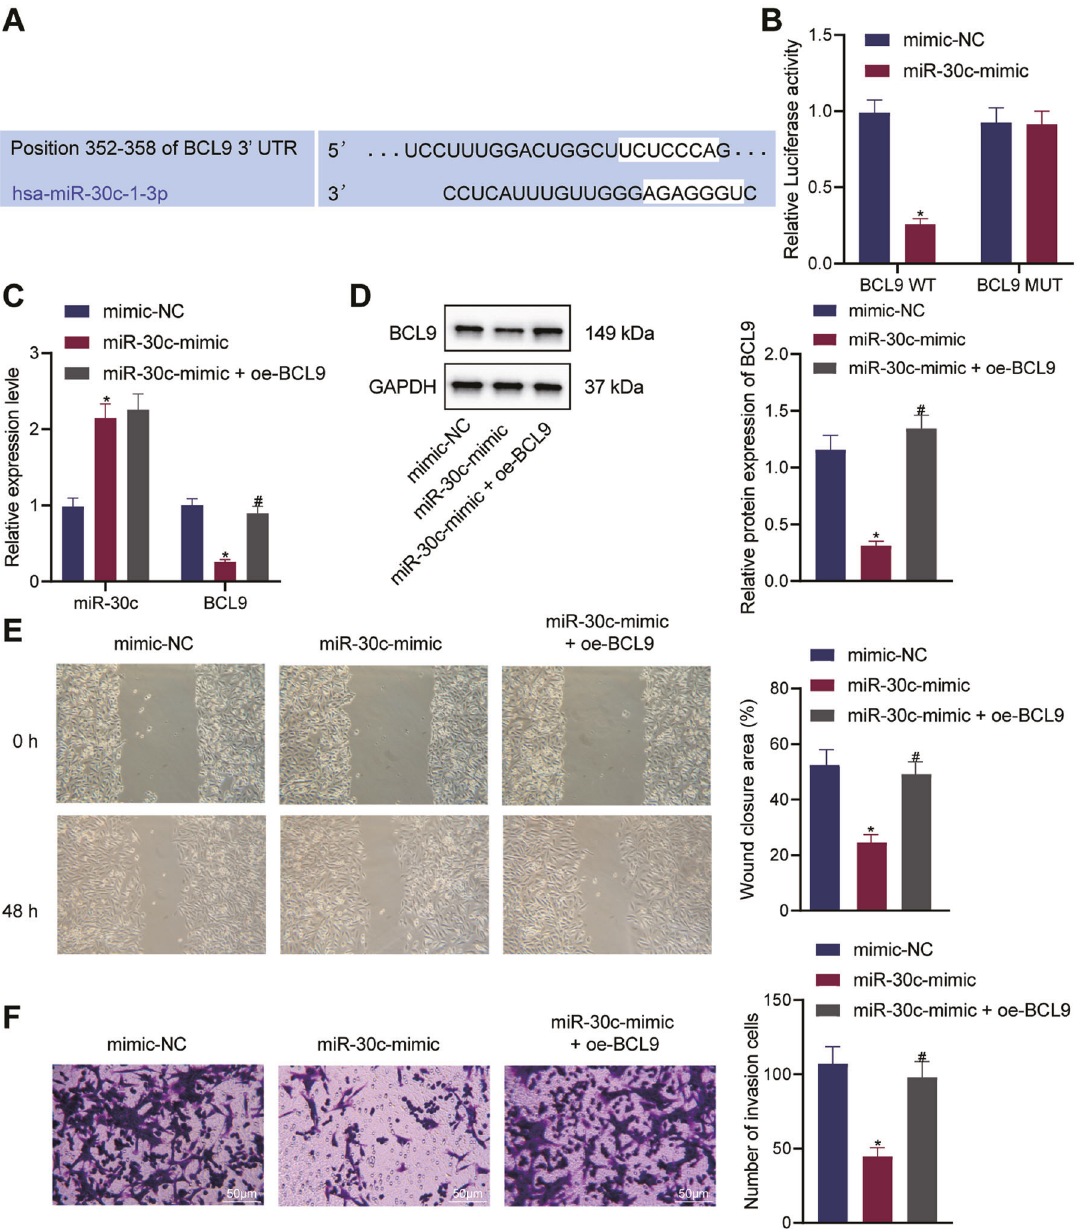
Fig. 3 miR-30c targeted and inversely regulated BCL9, thus repressing ecto-EEC migratory and invasive phenotypes. A Online prediction of the binding site of BCL9 and miR-30c by TargetScan; B Dual-luciferase reporter gene assay to verify the binding of miR-30c to BCL9; C qRT- PCR measurement of the expression of miR-30c and BCL9 in ecto-EECs in response to the overexpression of miR-30c alone or in combination with BCL9; D Western blot measurement of the protein expression of BCL9 in ecto-EECs in response to the overexpression of miR-30c alone or in combination with BCL9; E Wound healing assay to detect the migration of ecto-EECs in response to the overexpression of miR-30c alone or in combination with BCL9; F Transwell assay to detect the invasion of ecto-EECs in response to the overexpression of miR-30c alone or in combination with BCL9. Cellular experiments were repeated three times. Measurement data were characterized as mean ± SD. The comparison between data of two groups was performed by independent sample t -test and that among multiple groups was performed with one-way ANOVA with Tukey ’ s post hoc test. * p < 0.05 versus the mimic-NC group, # p < 0.05 versus the miR-30c-mimic recognized for its regulatory role in relation to endometrial cell Our initial fi nding through bioinformatics analysis indicated the apoptosis in EMs [20, 21]. Interestingly, miR-30c has been reported to poor expression of miR-30c and the overexpression of BCL9 in O- be poorly expressed in a variety of malignancies, such as colorectal EMs, which were then validated in clinically collected O-EMs ectopic carcinoma, glioblastoma, and urothelial carcinoma, and to exert tissues and ectopic EECs, indicating their involvement in the tumor-suppressive functions by impeding the biological behaviors of progression of O-EMs. These fi ndings corroborate a previous study cancer cells [22 – 24]. EMs, even as a relatively benign disease, shares where a downregulated expression has been observed in ectopic biological behaviors of invasion and migration with cancers [7]. In and eutopic endometriosis tissues [12]. Meanwhile, although BCL9 this study, our results unraveled that exosomes derived from normal has rarely been correlated with EMs, the BCL2 protein family is well-